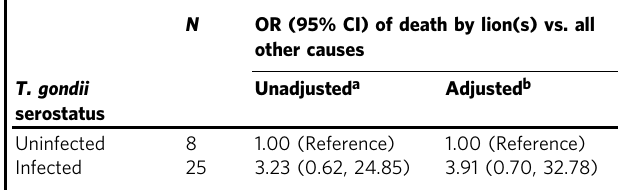
Table 3 Associations of T. gondii infection with odds of death by lion(s) among 33 hyenas. N OR (95% CI) of death by lion(s) vs. all other